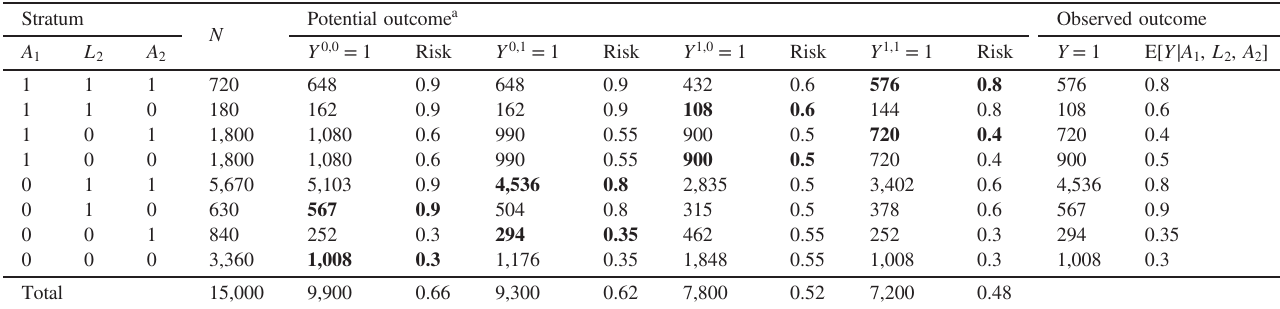
Table 2. Hypothetical cohort data with potential outcomes under time-varying exposure Stratum Potential outcome a Observed N